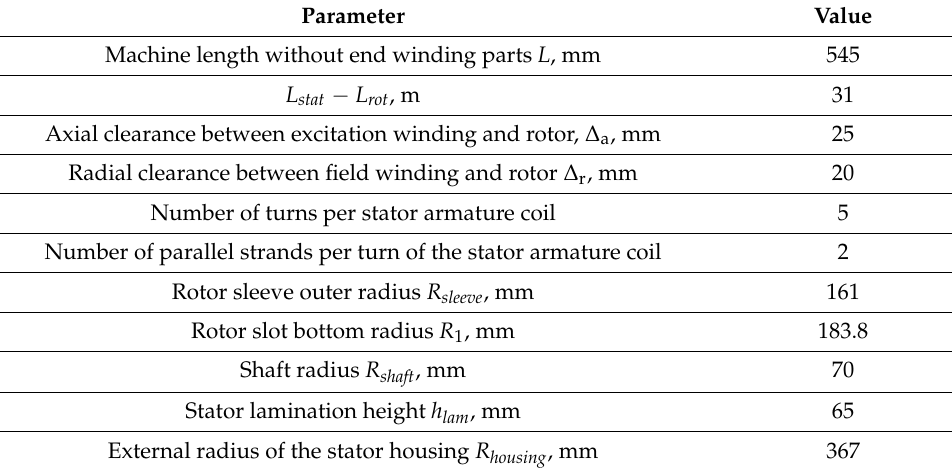
Table 3. Geometric parameters varied during the optimization.